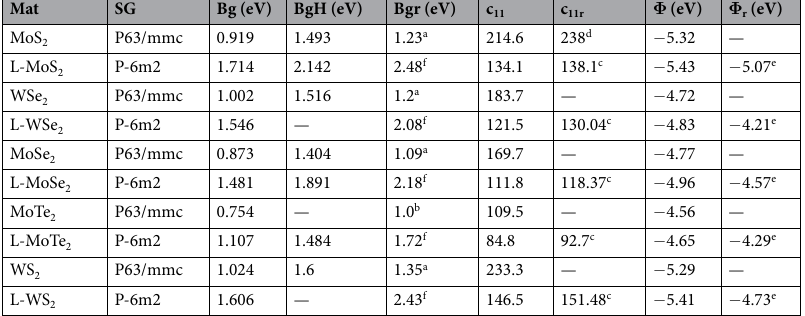
Mat SG Bg (eV) BgH (eV) Bgr (eV)